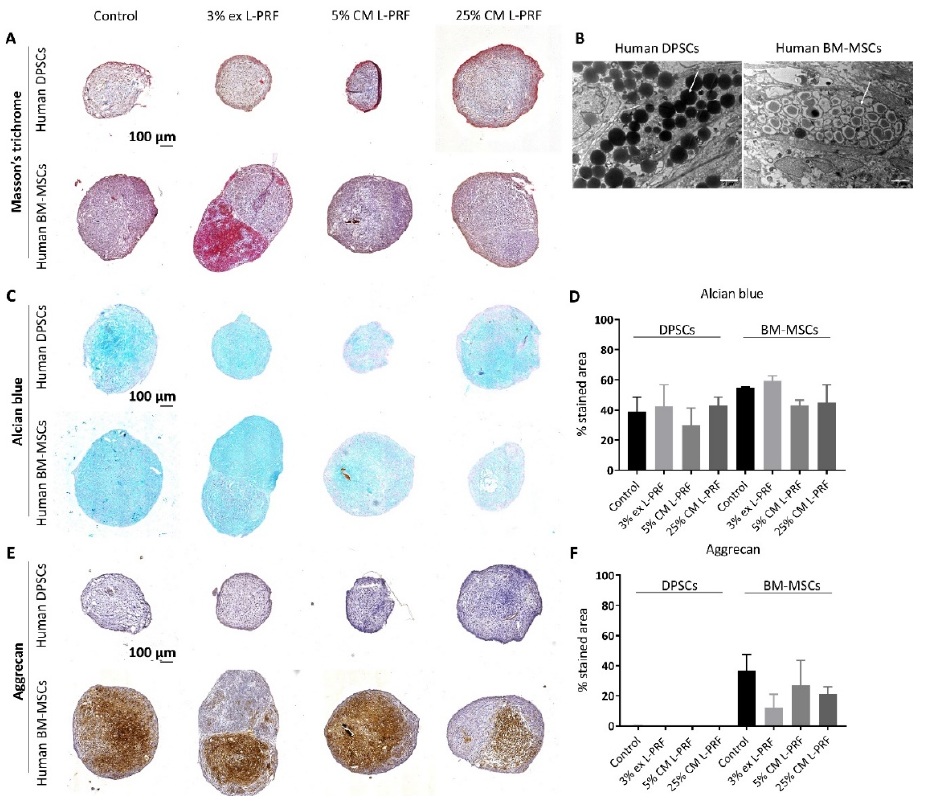
Figure 1. Differences in chondrogenic differentiation potential between human dental pulp stem cells (DPSCs) and human bone marrow-derived MSCs (BM-MSCs) and the effect of exposure to L-PRF during chondrogenesis. After 21 days of exposure to L-PRF ex (3%) or L-PRF conditioned medium (CM) (5% and 25%), cartilage-specific protein expression in differentiated pellets was evaluated using (immuno)histological staining ( n = 3). ( A ) Masson’s trichrome staining revealed the presence of abundant extracellular matrix (ECM) in micropellets derived from both differentiated stem cell types. ( B ) Ultrastructural analyses of the micropellets of both cell types showed the presence of dense matrix-filled vesicles (arrowheads). ( C ) Glycosaminoglycan (GAG) production was assessed by means of alcian blue staining. ( D ) L-PRF ex or L-PRF CM stimulation did not enhance the GAG area percentage. ( E ) Immunohistochemical (IHC) revealed that aggrecan expression was present in differentiated BM-MSCs, but absent in the DPSC-derived pellets. ( F ) Aggrecan area percentage was not enhanced by L-PRF ex or L-PRF CM exposure. Scale bars A, C, E = 100 μ m; B = 2 μ m. Data in D and F are represented as mean ± S.E.M.